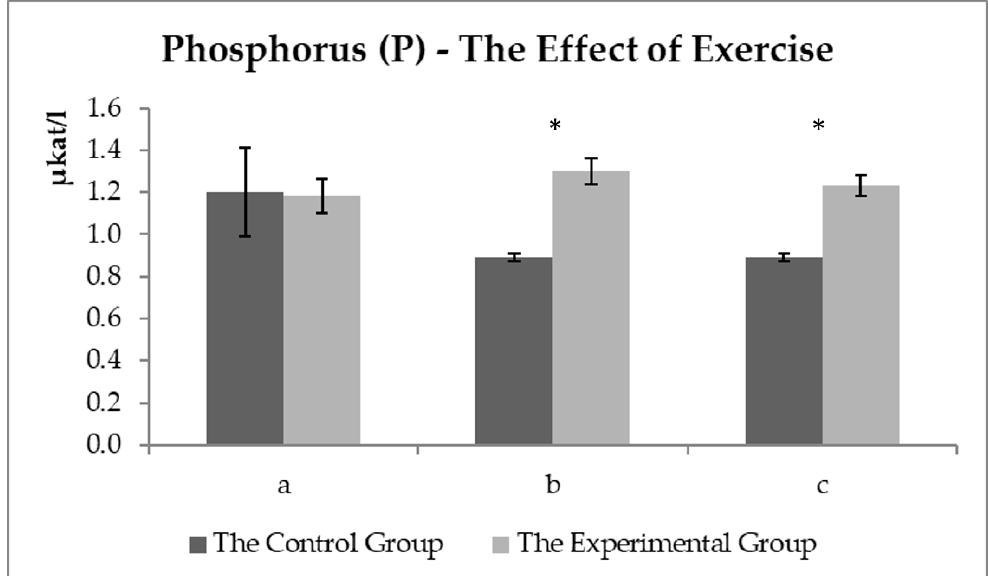
Figure 6. The phosphorus values ( µ kat/L) in the control and experimental groups: ( a ) the values before the start of the training—sample two; ( b ) the values about 15 min after the end of the training—sample three; ( c ) the values about 60 min after the end of training—sample four. * the symbol indicates a significant difference between the control and experimental groups at the level of p < 0.05.